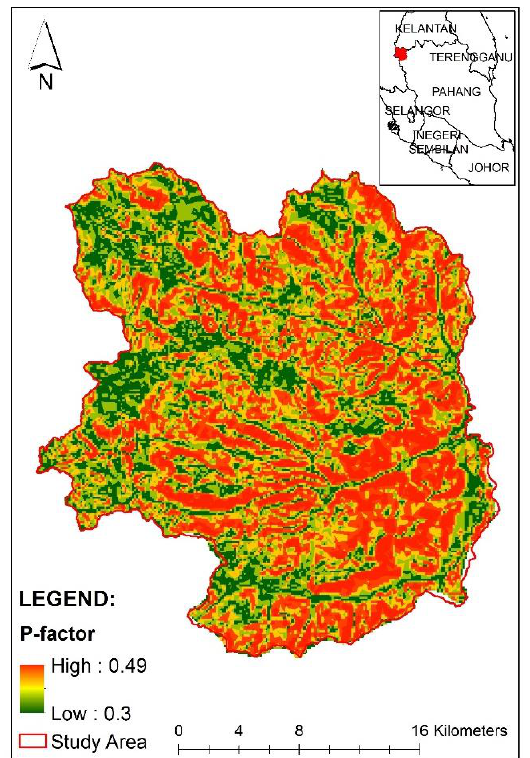
Figure 6. New P factor in Cameron Highlands district [21,23].